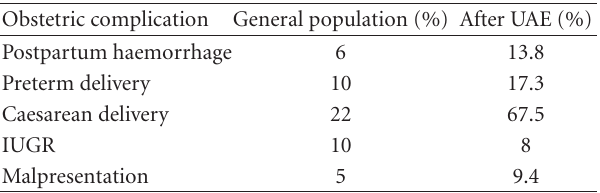
Obstetric complication General population (%) After UAE